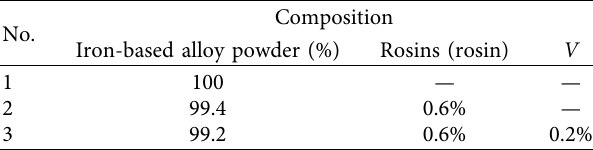
Table 2: Composition of the three types of